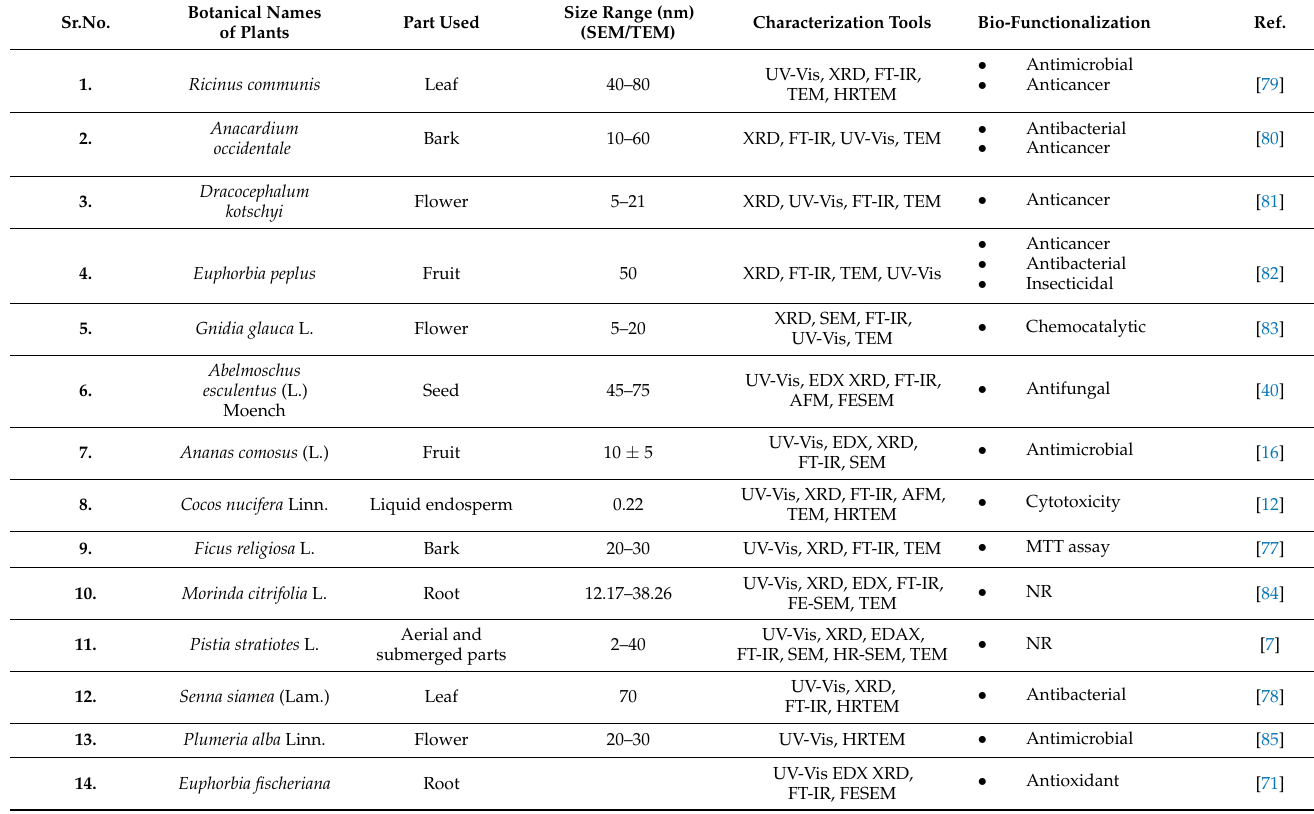
Table 2. Bio-reduction of gold NPs and their